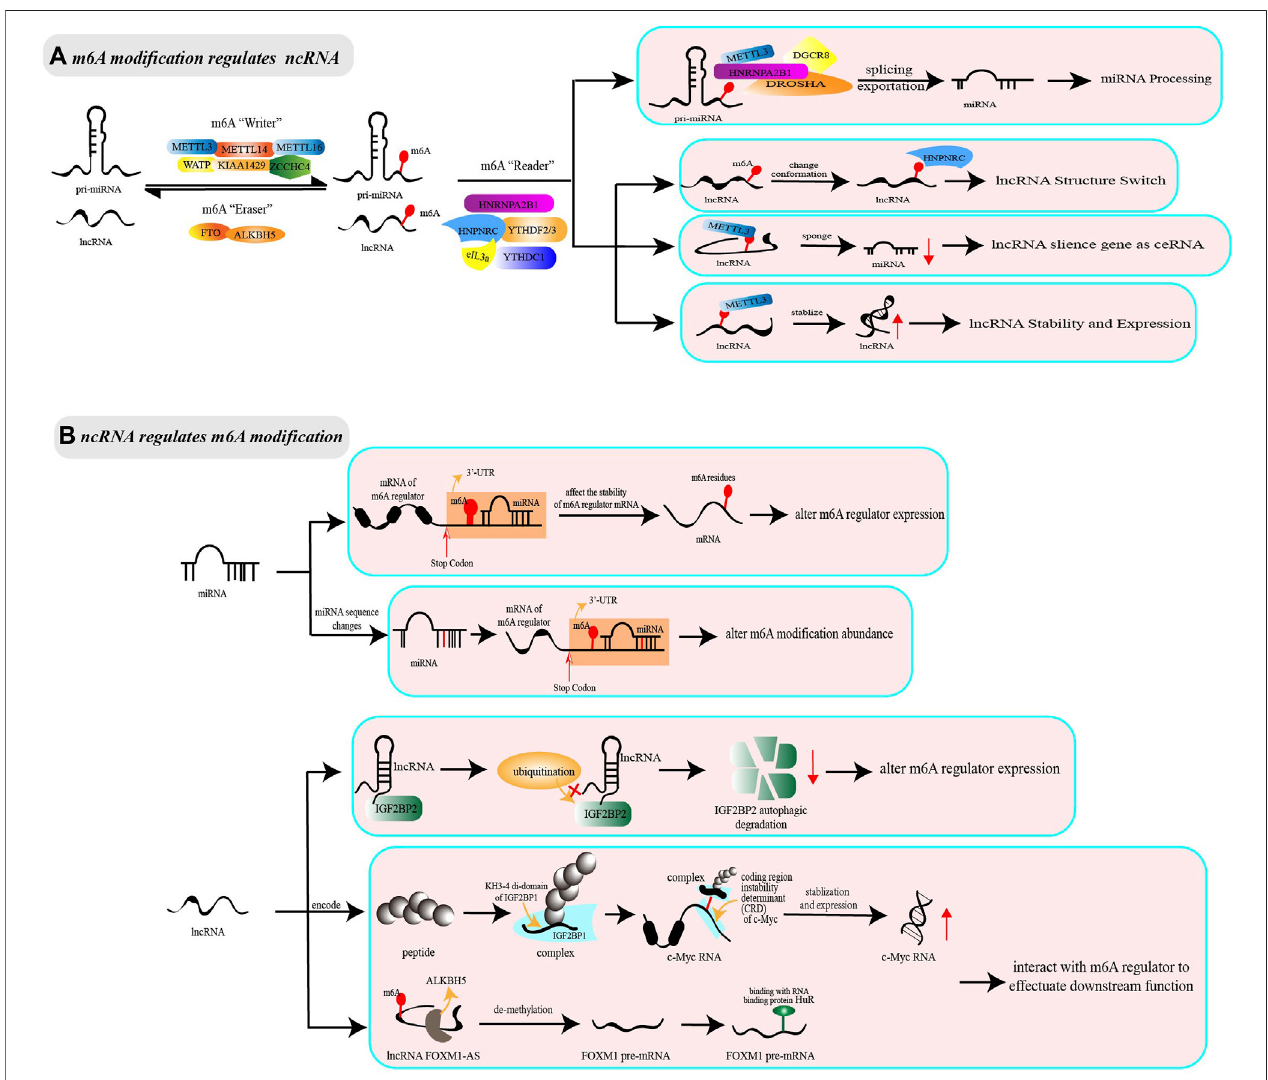
FIGURE 1 | The interaction between non-coding RNA and m6A modi fi cation. The adenosine(A) bases reside in non-coding RNA could be methylated by methyltransferase complex ( “ Writer ” ) comprised of METTL3/METTL14/WATP and other regulator cofactors. The non-coding RNA with m6A modi fi cation resides could by recognized by m6A binding proteins ( “ Reader, ” e.g. NRNPA2B1, HNRNPC, YTHDF) to effectuate downstream functions, or be reversibly erased by demethyltransferase( “ Eraser, ” e.g.FTO,ALKBH5). (A) m6Amodi fi cationregulatesncRNA.Duringtheprocessingfrompri-miRNAtomiRNA,thepresenceofm6A in lncRNA. The lncRNA marked m6A writer proteins could change conformation to bind to proteins, leading to that m6A modi fi cation is regarded as lncRNA structure switchandfacilitatetheRNA-proteininteraction.Secondly,thelncRNAwhichismethylatedbym6AwriterproteinshavetheeffectonspongingmiRNAasceRNA,greatly augmenting the RNA-RNA interaction. For lncRNA itself, m6A modi fi cation could regulate transcript stabilization and expression level to activate or participate in subsequent functions. (B) ncRNA regulates m6A modi fi cation. Non-coding RNA could regulate m6A modi fi cation from the perspective ofexpression level and function. MiRNAintegrateintothemRNA3 ′ -UTRregionofm6Aregulatorcofactors,whichalterstheexpressionlevelofm6Aregulatorsandindirectlyin fl uencesontheabundance of m6A modi fi cation. Differently, lncRNA can alter the expression level of m6A regulators by affecting the stability and degradation of mRNA. Notably, lncRNA or RNA- bindingregulatorypeptidethatisencodedbylncRNA(e.g.LncRNALINC00266-1)hasthecapabilitytobindwithm6Aregulatortostrengthenm6Arecognition,therefore affecting the stabilization and expression of the downstream target mRNA. Anti-sense lncRNA could recruit m6A eraser proteins to decrease m6A abundance on the sense mRNA to active downstream effects (e.g. lncRNA FOXM1-AS and m6A eraser ALKBH5).